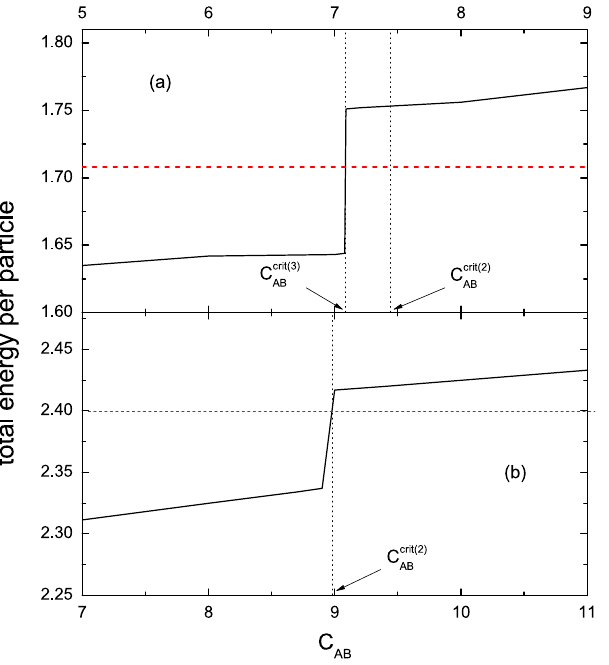
Figure 3. E tot / N (in solid line for the lowest symmetric state) and E N / totasym (in horizontal dash line for the lowest asymmetric state) versus c AB . Other parameters in ( a , b ) are the same as in Figs 1 and 2, respectively. The unit ħ ω is used for energy, and 10 − 4 ħ ωλ 3 for c AB . Note that the ranges of c AB in ( a , b ) are